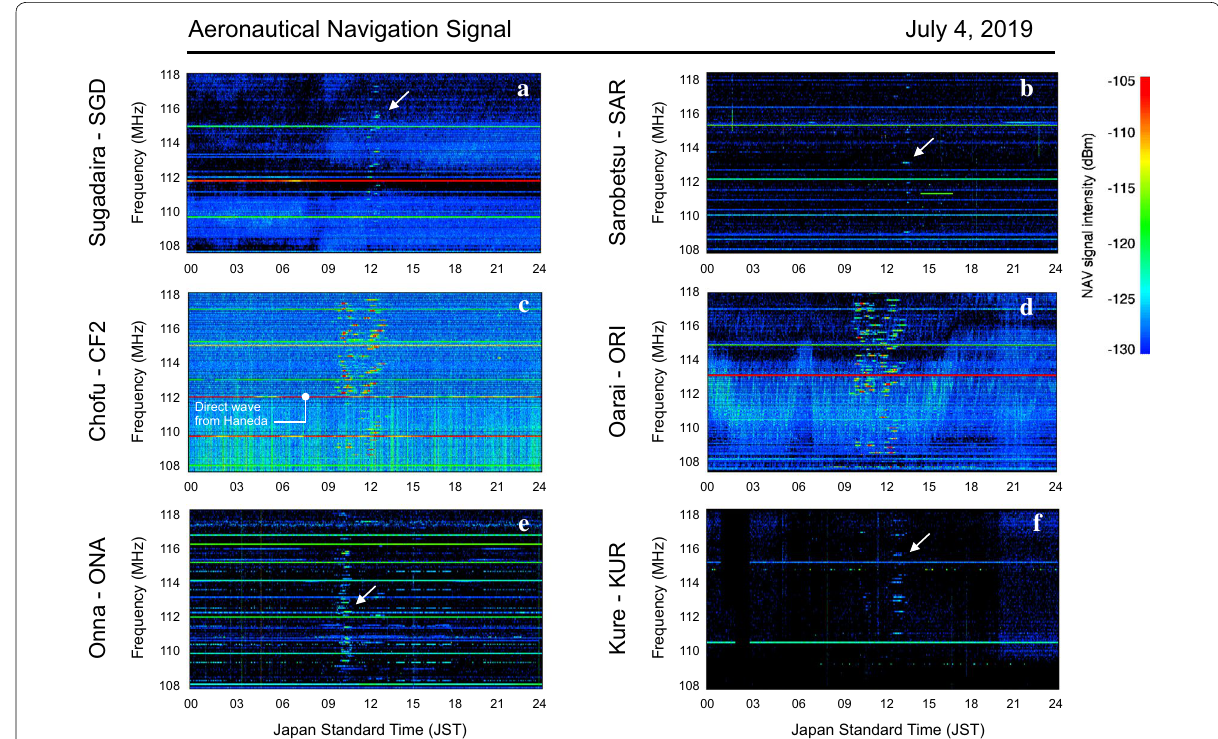
Fig. 4 An example of Es event on July 4, 2019. Data from all the 6 Rx stations are shown in a format of spectrogram for 24 h in